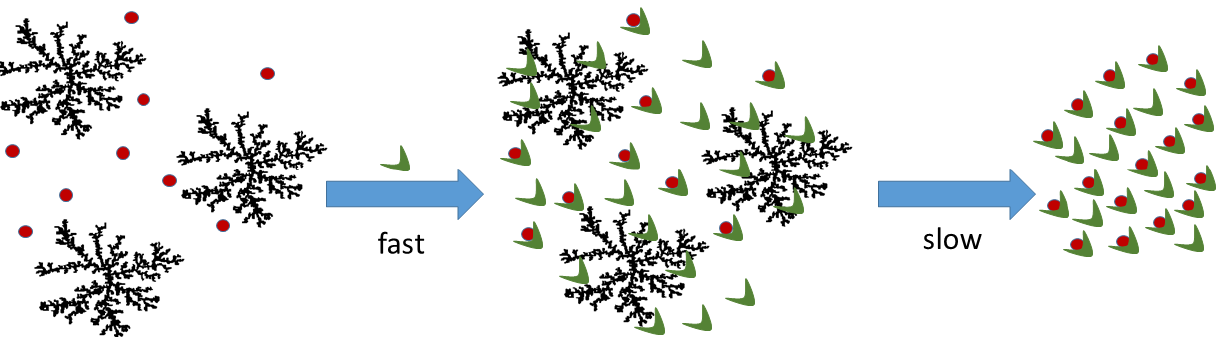
Scheme 2. Model for the interaction of aggregated (black clusters) and monomeric (red circles) t-H 2 Pagg and HSA (green).